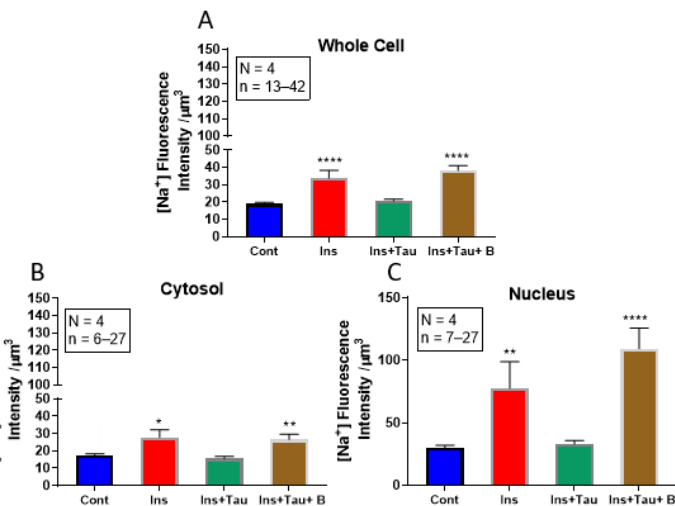
Figure 5. Histograms showing the effect of 48-h treatment with insulin (80 µ U/mL), insulin (80 µ U/mL) with taurine (20 mM), or insulin (80 µ U/mL) with taurine (20 mM) and β -alanine (500 µ M) on whole-cell ( A ), cytosolic ( B ), and nuclear ( C ) sodium levels of cardiomyocytes. The values are represented as mean ± standard error of the mean. N represents the number of animals, and n represents the number of cells. * p < 0.05, ** p < 0.01, and **** p < 0.0001. Cont = control; ins = insulin; tau = taurine, and B = β -alanine. Sodium relative concentration is expressed in µ m 3